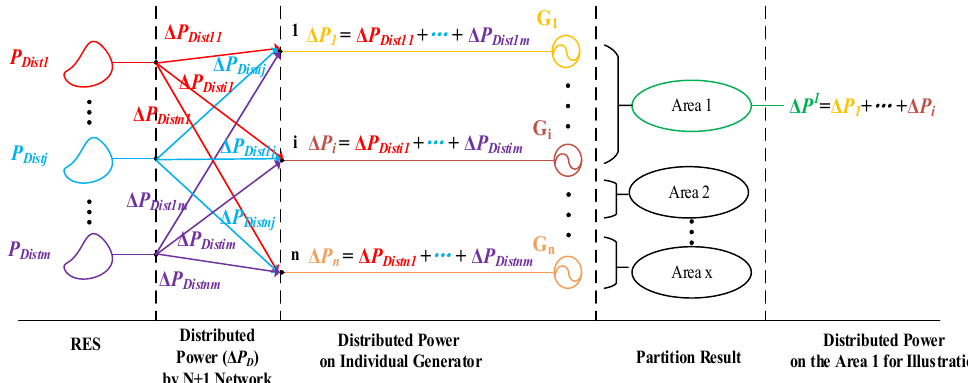
Figure 2. The propagating procedure of the active power disturbances in the multi-RES penetrated power system and the derivation of the regional active power disturbance.